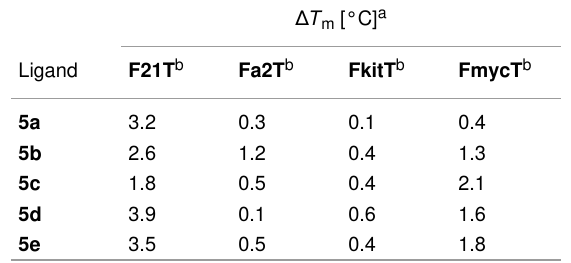
Table 2: Shift of melting temperature, ∆ T m, of oligonucleotides F21T , Fa2T , FmycT and FkitT in the presence of berberine derivatives 5a – e